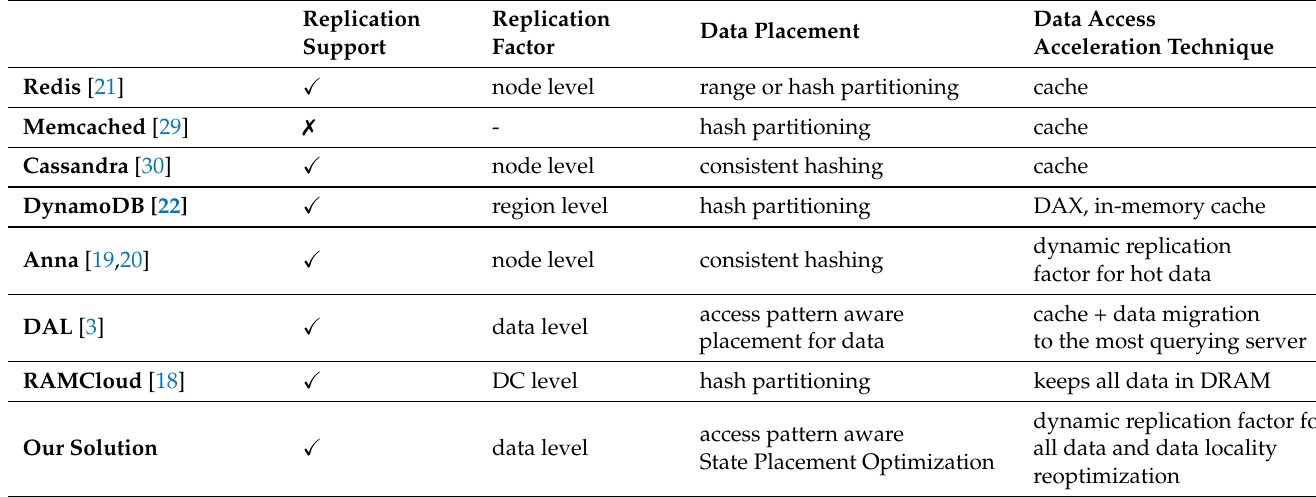
Table 6. Comparative analysis of state-of-the-art stores and our proposed